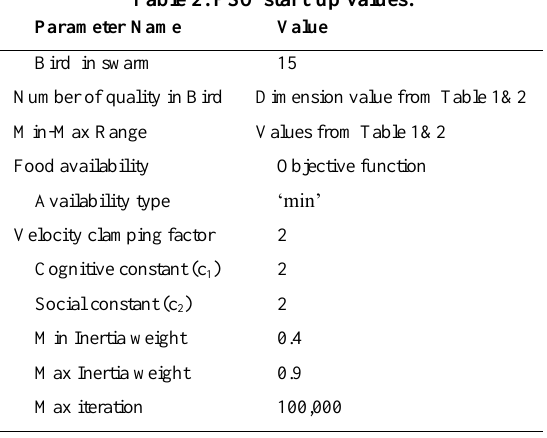
Table 2. PSO start-up